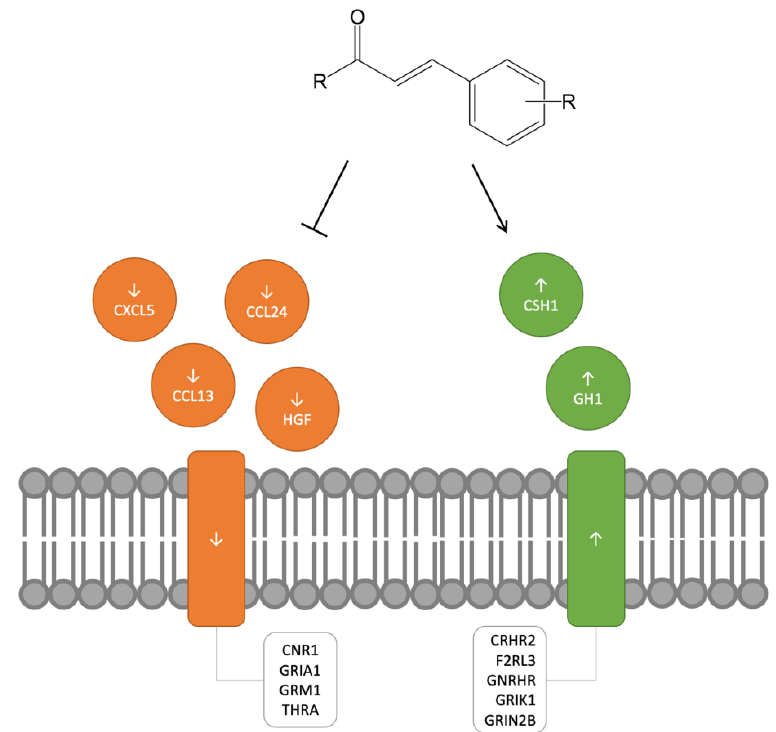
Figure 3. Association of fifteen transcripts identified in significantly up and downregulated KEGG pathways (cytokine-cytokine receptor interaction and neuroactive ligand-receptor interaction) and common to all five exposures to cinnamon-based phenylpropanoids.